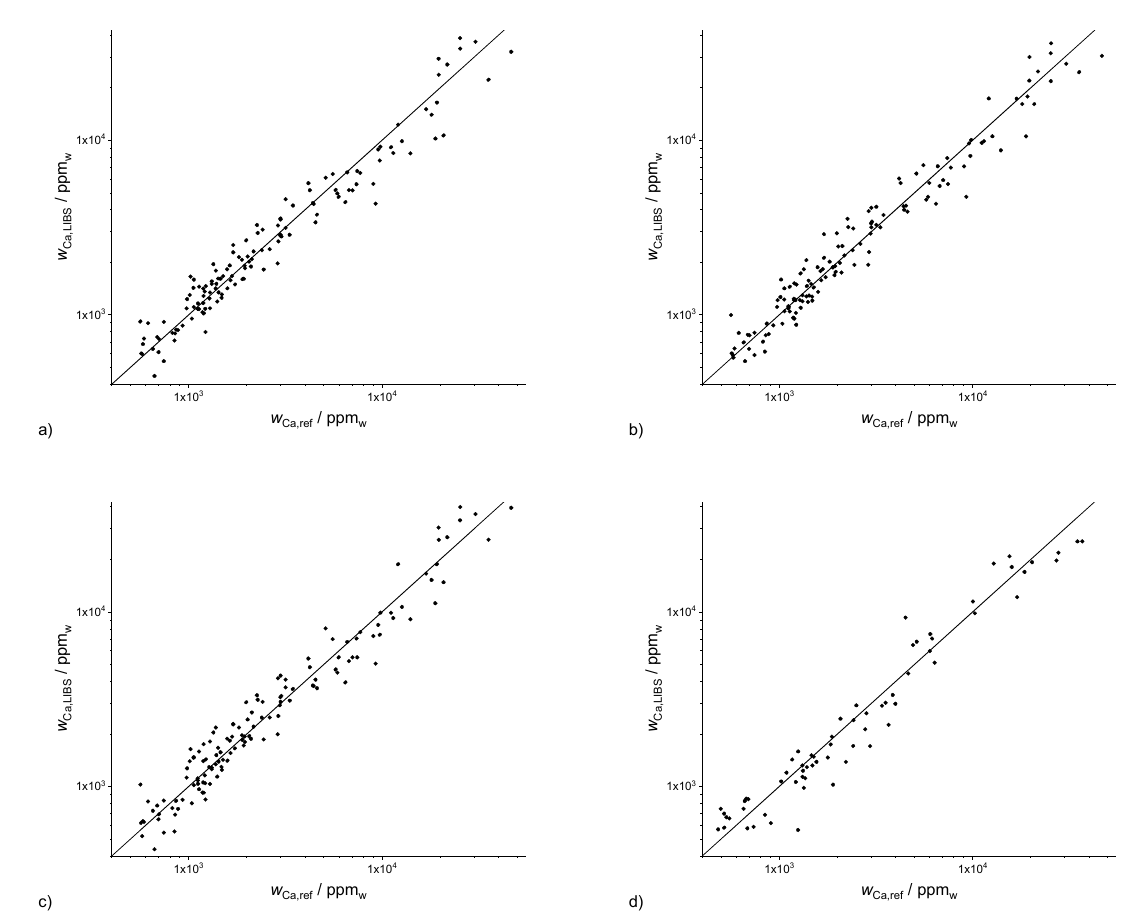
Figure 2. Results of 10-fold cross validation of Ca data for different multivariate methods ( a ) Lasso regression (R 2 (log) = 0.85), ( b ) Gaussian process regression (GPR) (R 2 (log) = 0.89), ( c ) partial least squares regression (PLSR) (seven components, R 2 (log) = 0.87), and ( d ) PLSR of second field (six components, R 2 (log) = 0.90).